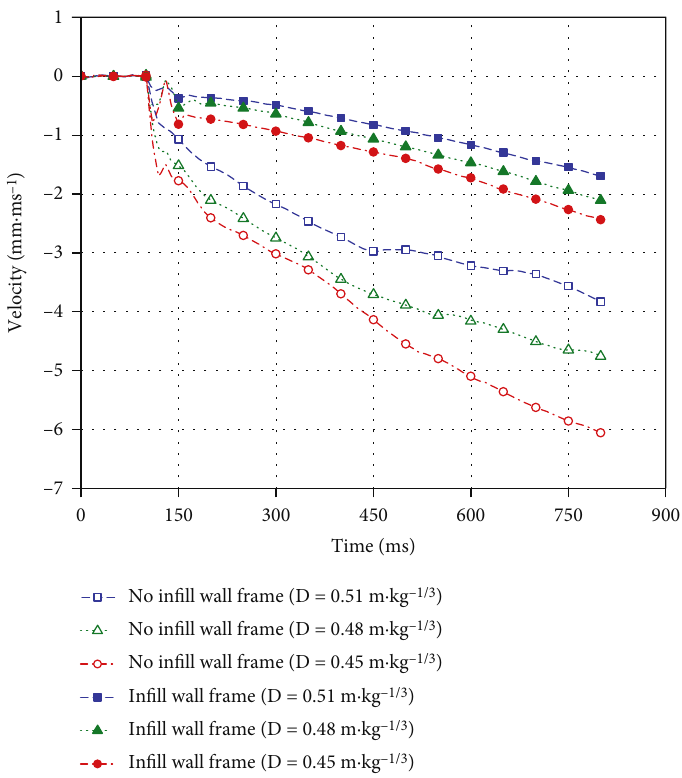
Figure 7: The z -directional velocity at the apex of the bottom middle